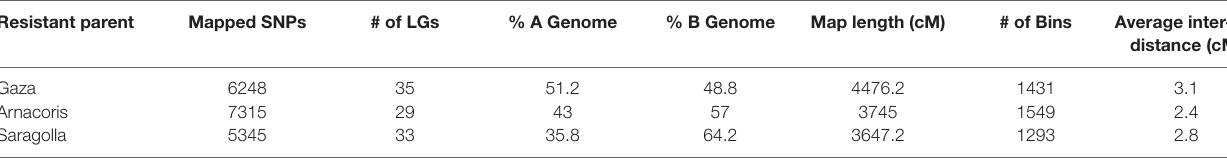
TABLE 2 | Statistics of the three linkage maps from the three RIL populations Gaza/ATRED #2, Arnacoris/ATRED #2 and Saragolla/ATRED #2.